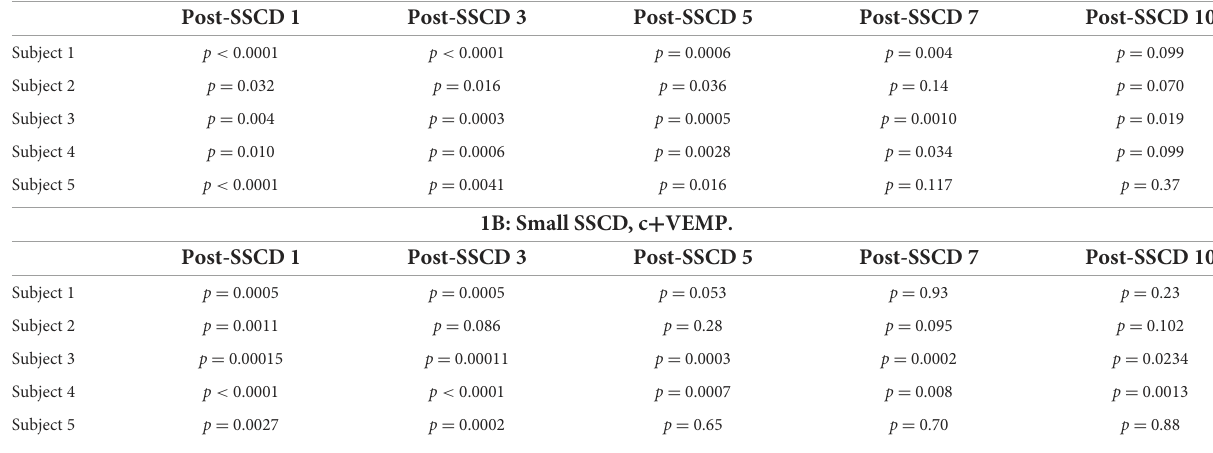
1A: Small SSCD, ABR.